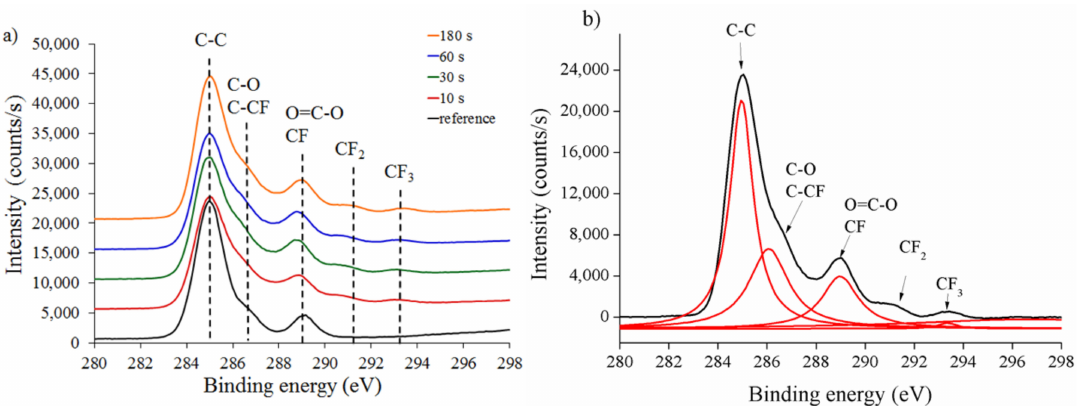
Figure 7. PCL1 ( a ) XPS survey spectra at various times and ( b ) peak deconvolution at 180 s. The “reference” represents the untreated (0 s treatment) PCL1 sample.